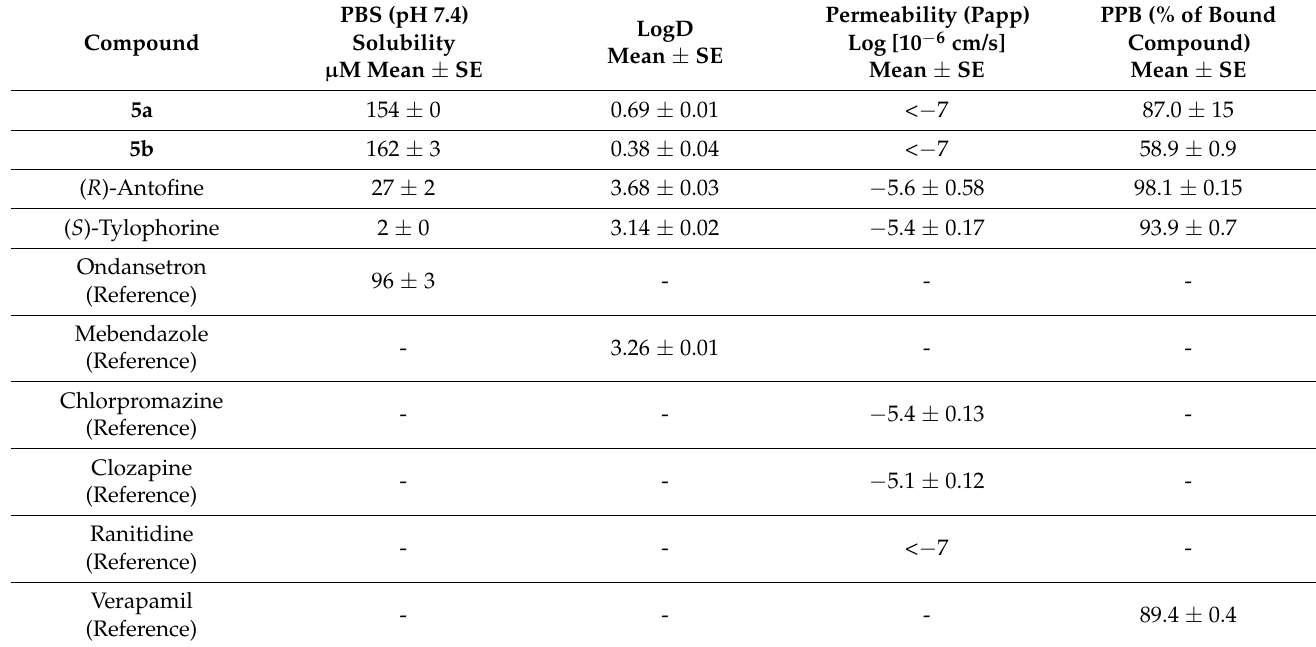
Table 1. Physiochemical properties prodrugs 5a,b and their parent alkaloids.